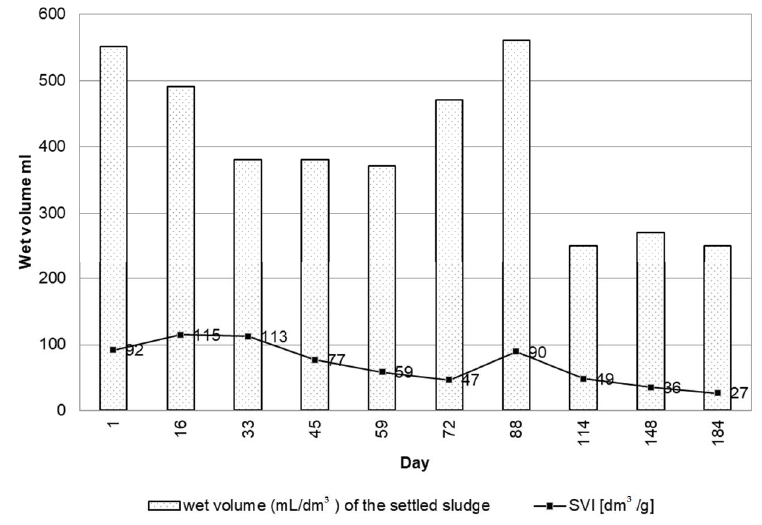
Figure 15. Results of sedimentation tests conducted from the 1st to 184th day of operation (April–October